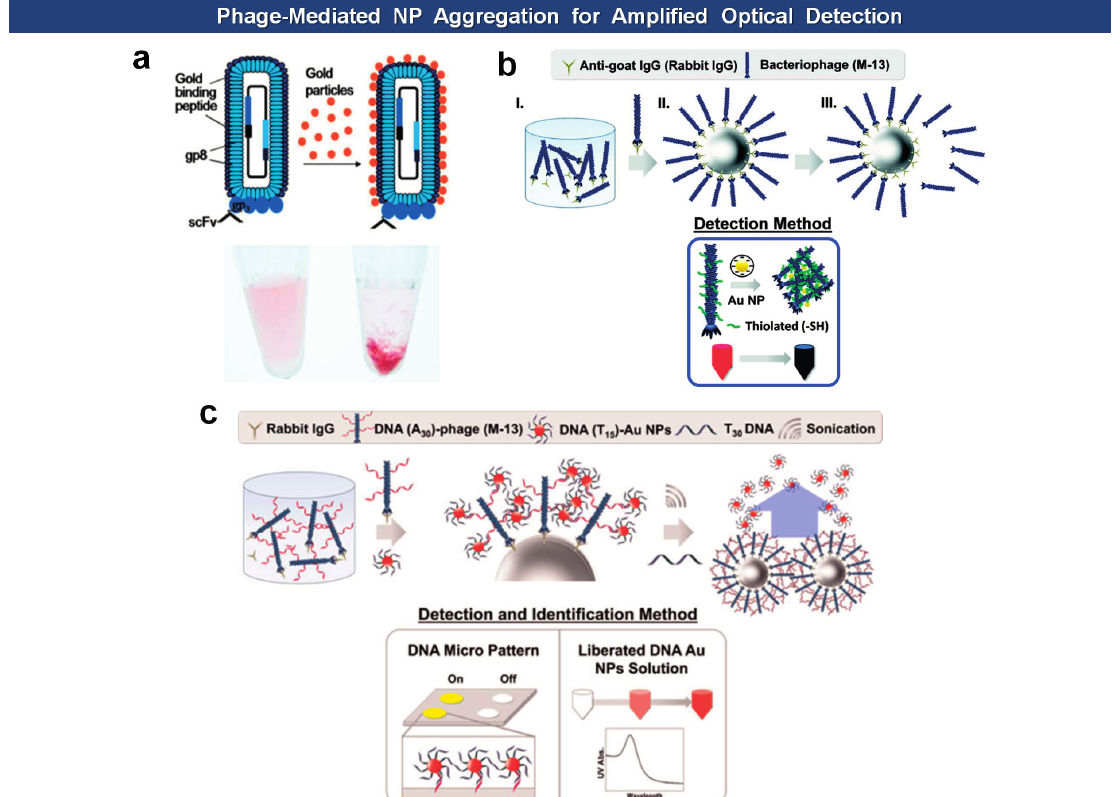
Figure 8. Antigen-specific phages displaying Au-binding motifs ( a ); thiol groups ( b ); or ssDNA ( c ) on their surfaces aggregate in the presence of Au particles [85,88] or